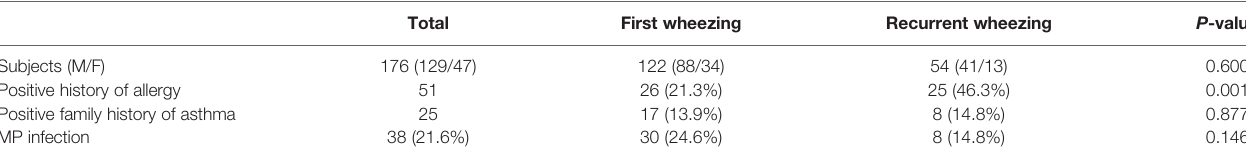
TABLE 1 | Clinical data of 176 wheezing children from Xiangya